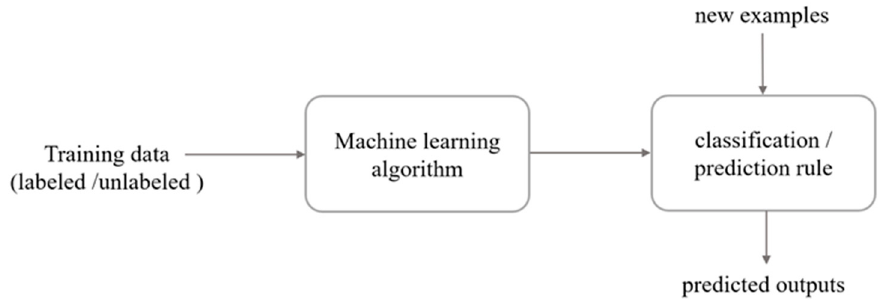
Figure 1. A typical machine learning approach.